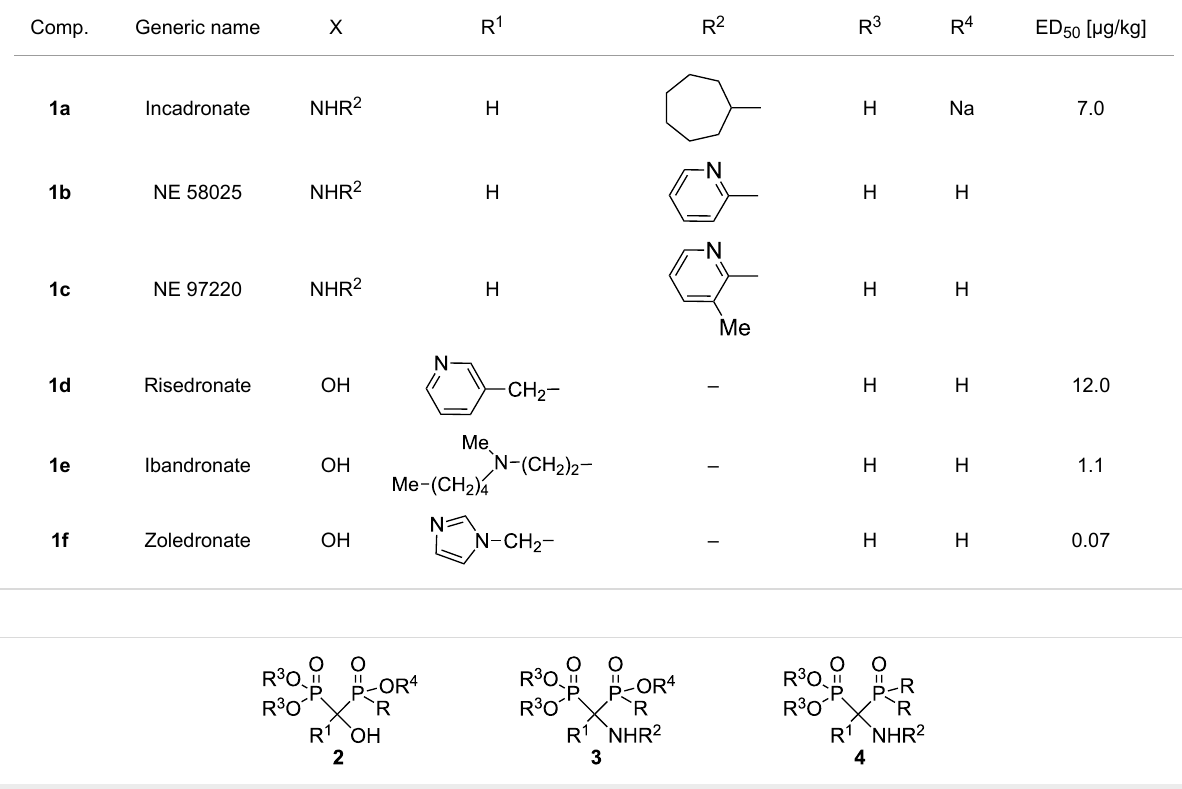
Table 1: Antiresorptive potency of selected α -amino and α -hydroxy derivatives of bisphosphonates [3,7,8]. Comp.